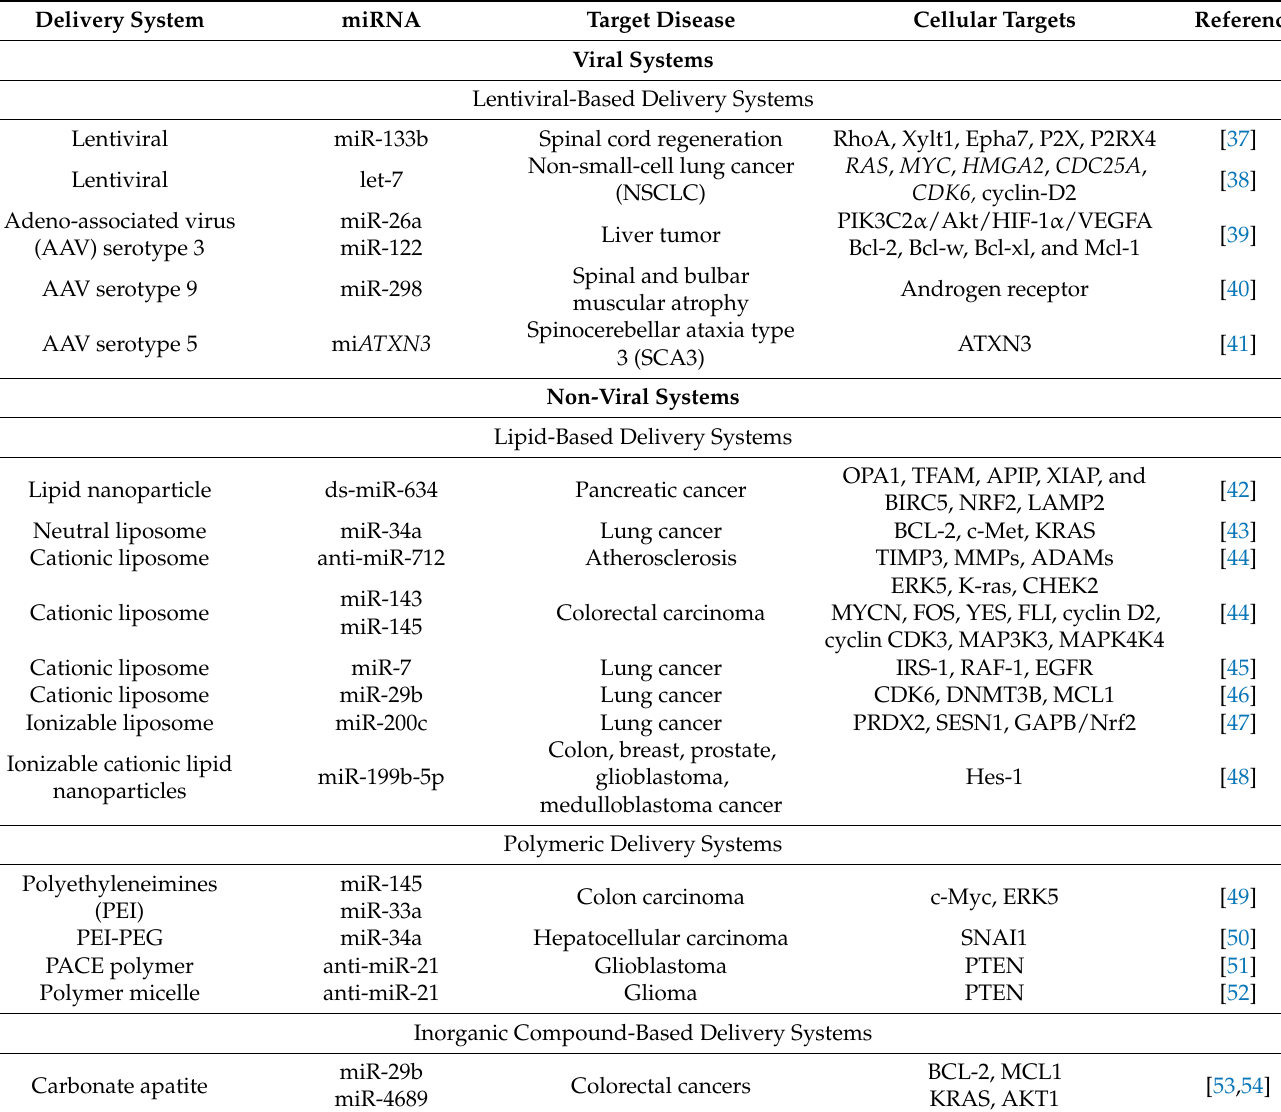
Table 1. Selected list of miRNA-based